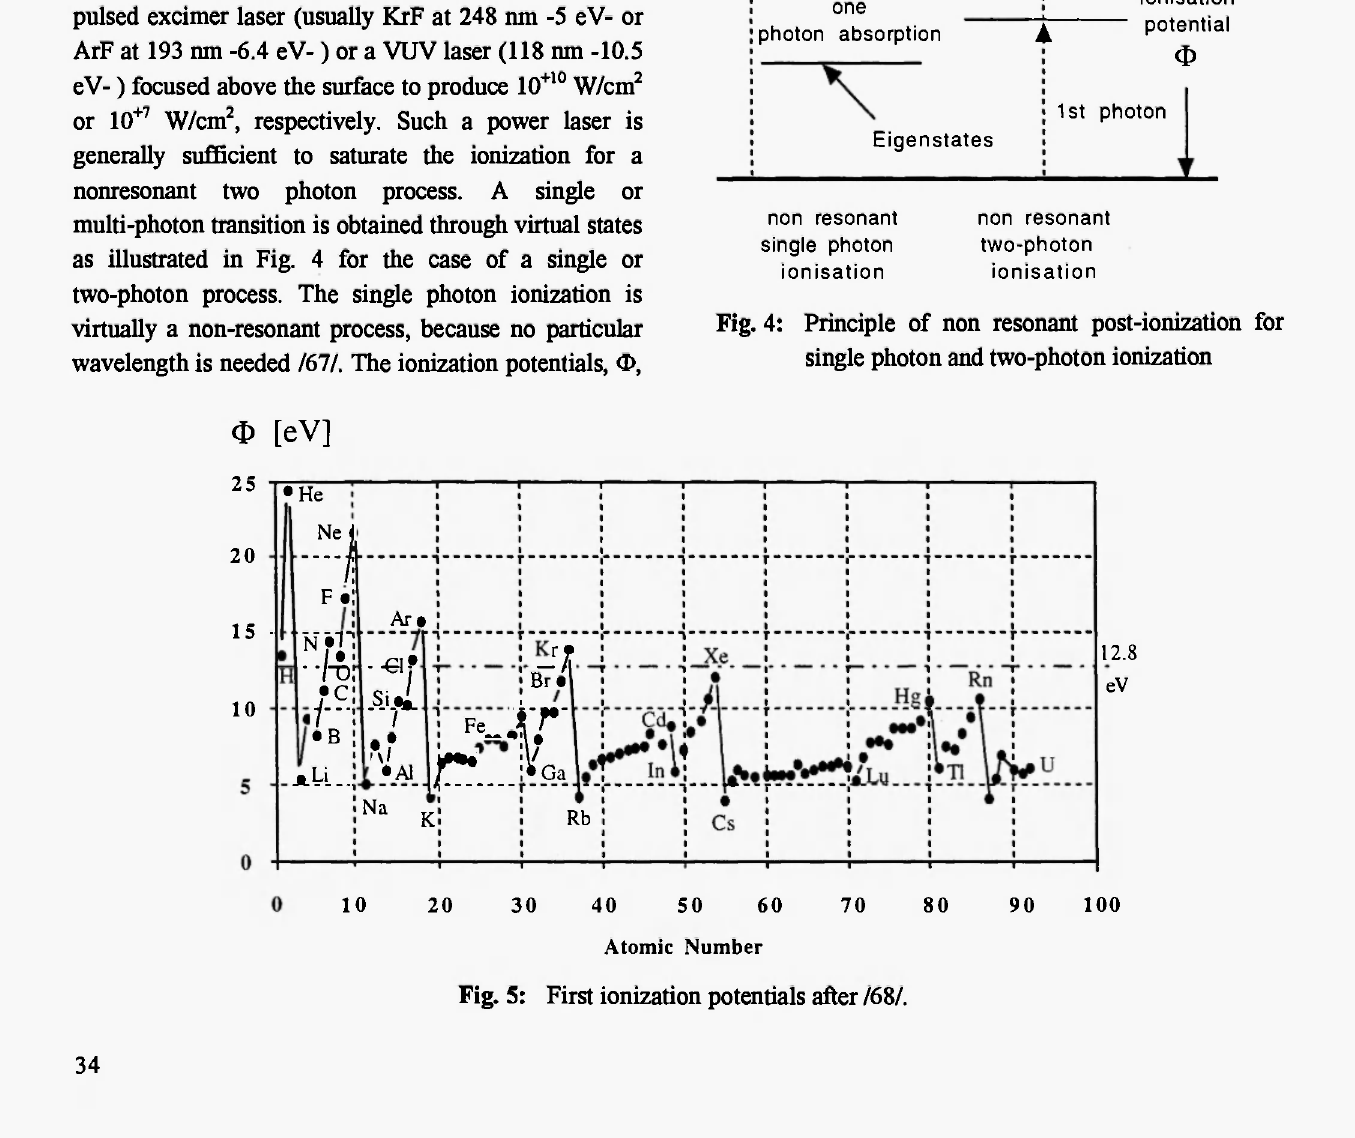
Fig. 5: First ionization potentials after